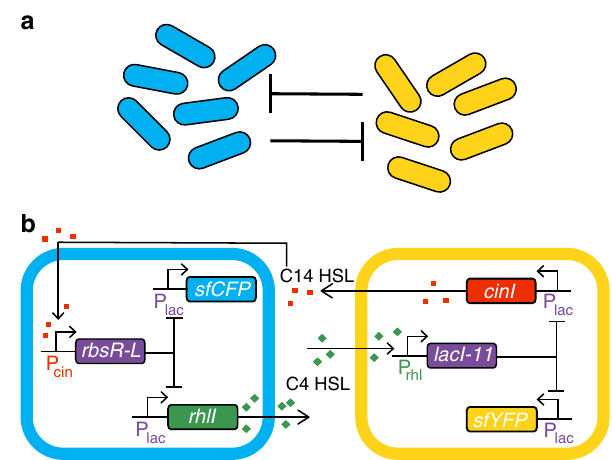
Fig. 1 Co-repressive consortium circuit. a The regulatory structure of the co-repressive consortium in which each strain downregulates production of QS molecule and fl uorescent protein in the other strain. b A detailed genetic circuit diagram of the co-repressive consortium. The cyan strain produces C4-HSL via the RhlI QS synthase. C4-HSL induces the expression of LacI-11 in the yellow strain. LacI-11 shuts off CinI and sfYFP in the yellow strain. 3OHC14-HSL produced by the CinI QS synthase in the yellow strain induces expression of RbsR-L in the cyan strain. RbsR-L shuts off RhlI and sfCFP in the cyan